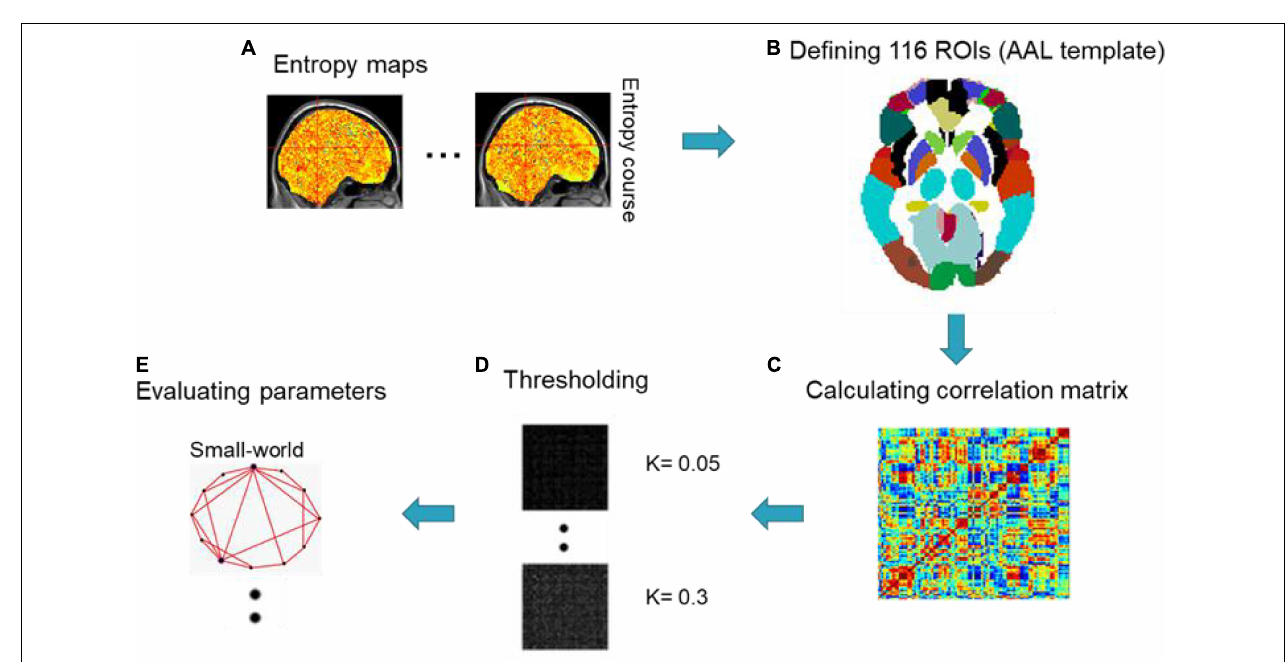
FIGURE 3 | Framework of dynamical entropy-based complex network analysis.